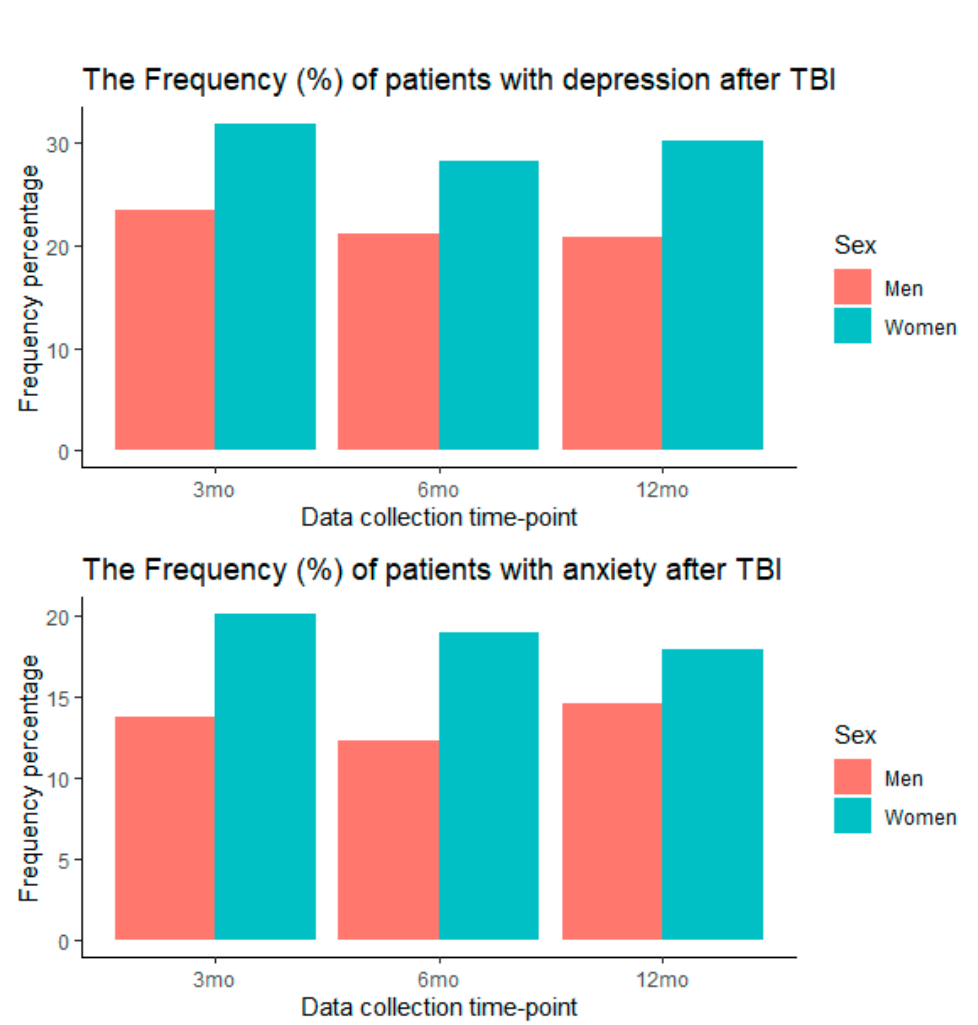
Figure A4. The percentage of sample with depression and anxiety for women and men.